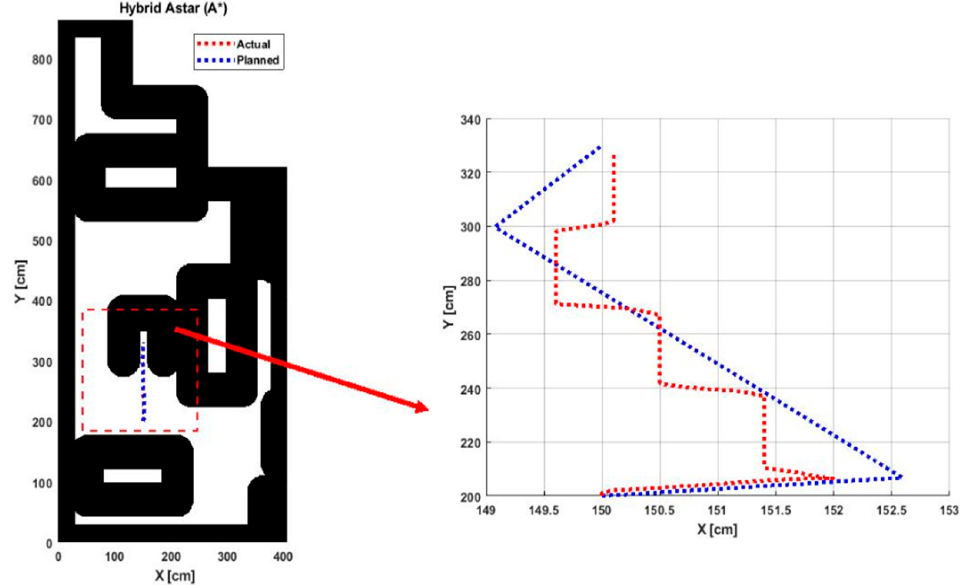
Figure 7. The experimental path that is generated by using Hybrid A* in Map1. The blue line is the planned path, while the red line is the actual robot’s path.